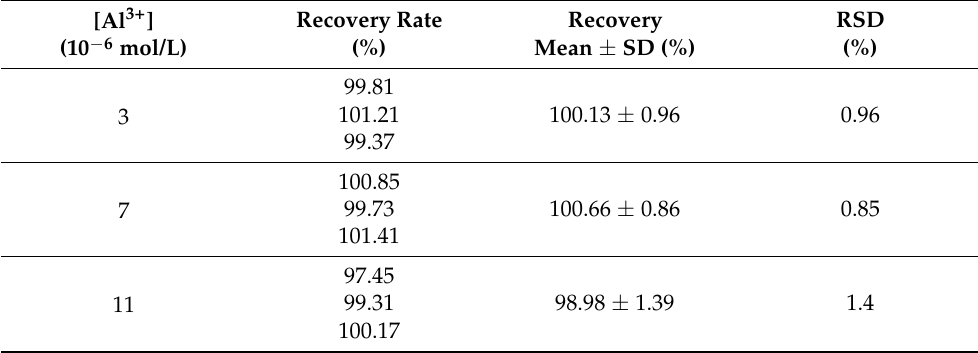
Table 2. Accuracy test of the F6 probe for Al 3+